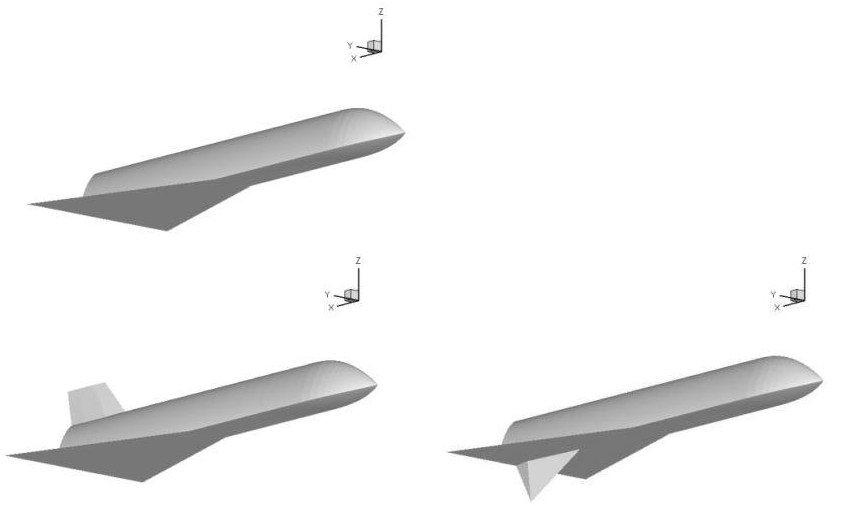
Figure 7. The original and modified configurations of hypersonic vehicles [20].